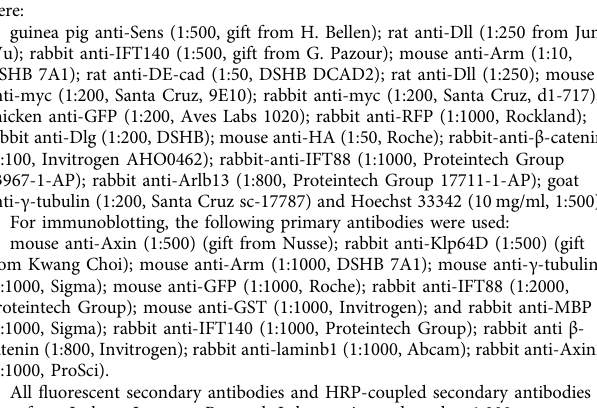
Fig. 9 β -cat* and β -catS33Y stable isoforms require IFT140 for nuclear localization in MEFs. a − d Nuclear and/or cytoplasmic accumulation of full-length β - catenin ( β -catFL-GFP), and mutant isoforms of β -cat tagged with GFP ( β -catS10-GFP, β -cat*-GFP, and β -catS33Y-GFP) or GFP alone were determined by western blots of nuclear and cytoplasmic cell fractions (without treatment of Wnt3A). γ -tubulin and Lamin B were used as loading controls. Note that the β -catS10 activated isoform localizes to the nucleus independent of the ift140 activity, whereas the β -cat* and β -catS33Y isoforms require IFT140 (compare panels ( a ) and d ). None of the activated β -catenin isoforms requires IFT88 (compare panels ( c ) and d